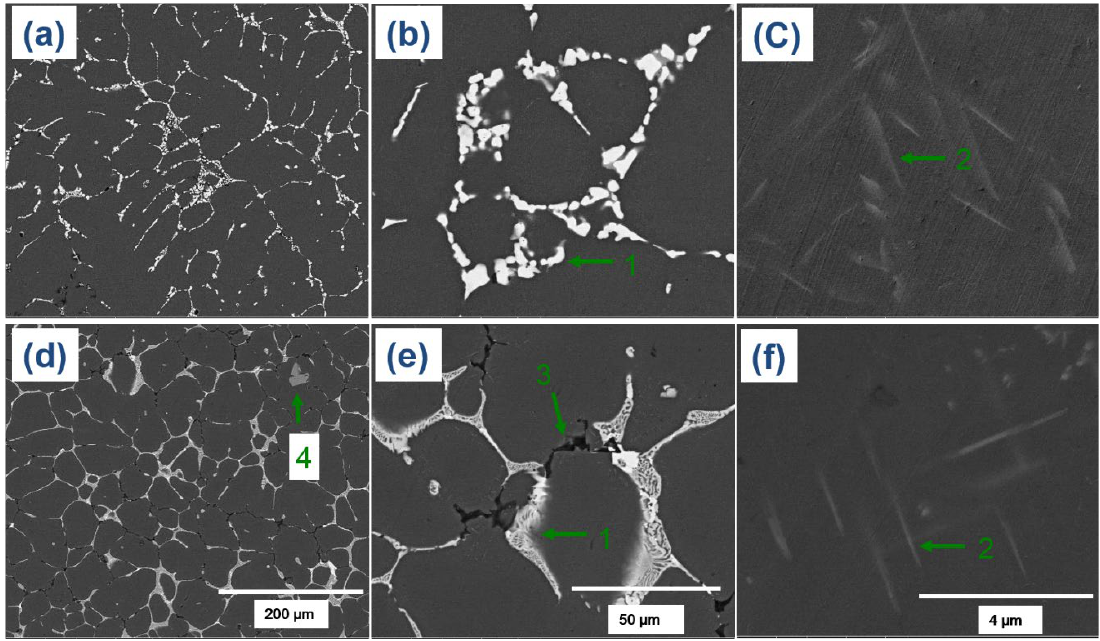
Figure 4. FE - SEM micrographs of the investigated alloys in their as - cast condition. The microstruc- tures of the B43 alloy are shown in ( a – c ), while ( d – f) show the microstructures of the S43 alloy. The annotations (1), (2), (3), and (4) indicate the eutectic Al - S, T precipitates, eutectic Al - Mg 2 Si, and Ti - based intermetallic phases, respectively.